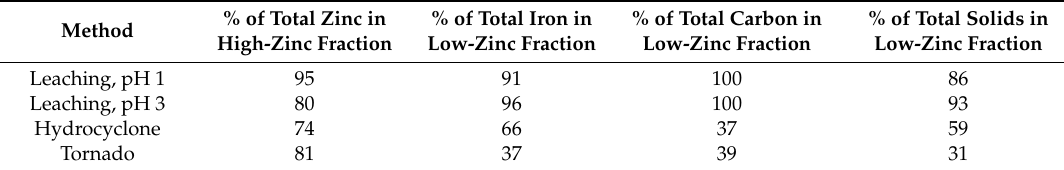
Table 6. Results of the upgrading of BF